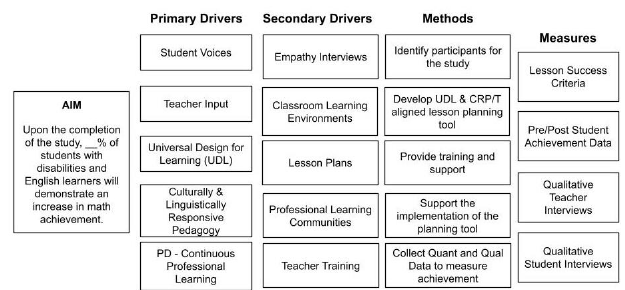
Figure D4. Nicole's Driver Diagram at the Beginning of the Course